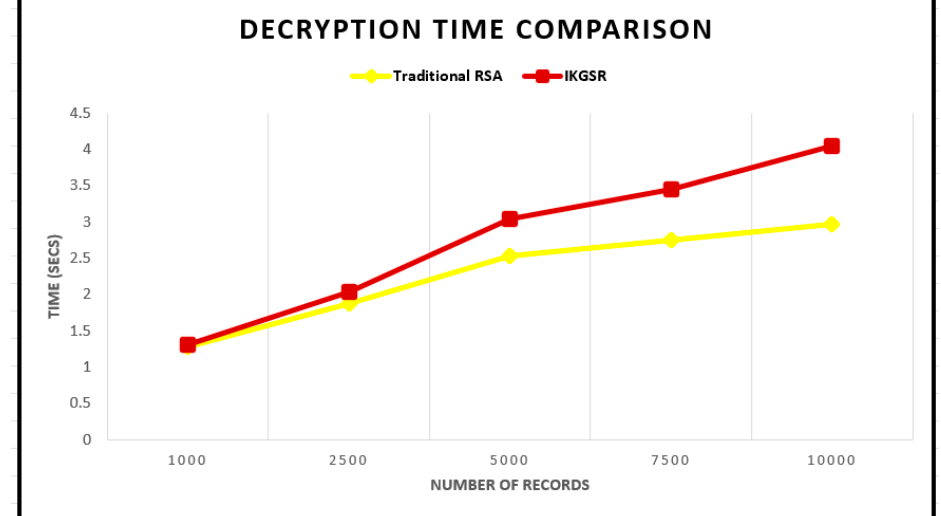
Figure 11. Decryption Time Comparison against Traditional RSA.